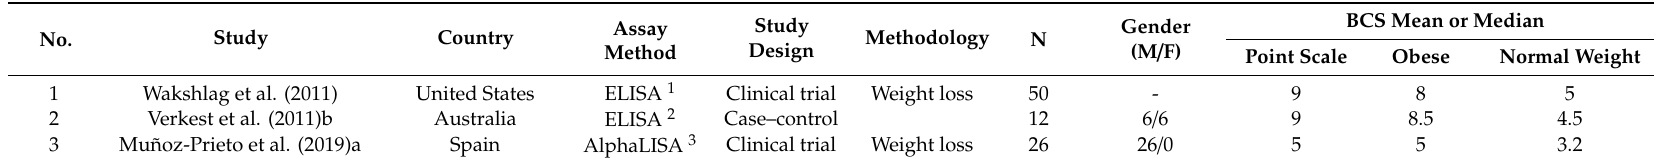
Table 2. Study characteristics of studies determining serum or plasma high molecular weight (HMW) adiponectin concentrations included in the meta-analysis.